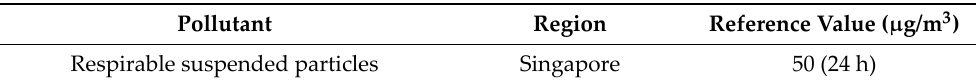
Table 15. Reference values for respirable suspended particles. Pollutant Region Reference Value ( µ g/m 3 ) Respirable suspended